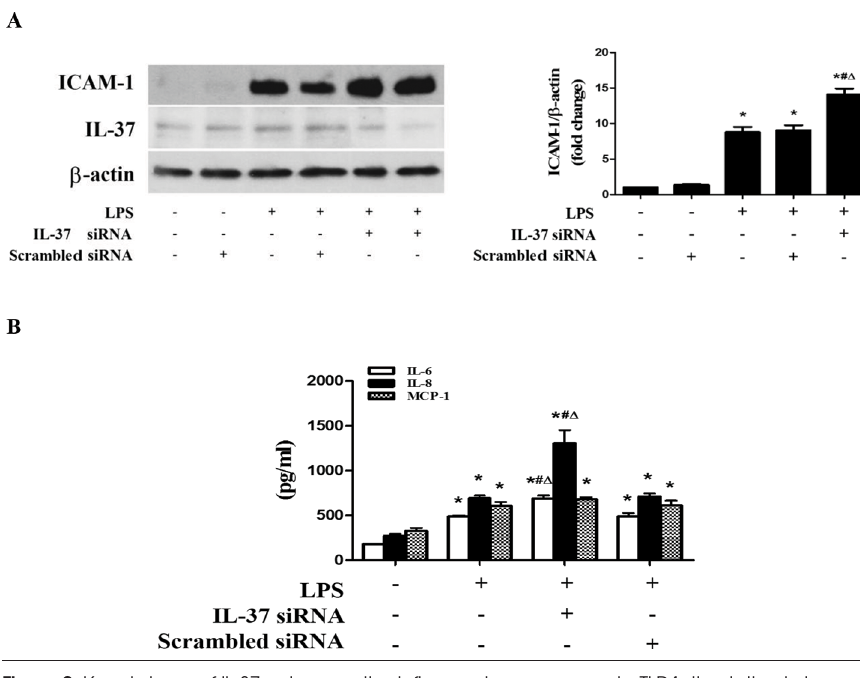
Figure 2. Knockdown of IL-37 enhances the inflammatory responses to TLR4 stimulation in human AVICs. AVICs were pretreated with IL-37 siRNA (60 nmol/L) or scrambled siRNA (60 nmol/L) for 48 h and then treated with LPS (0.1 μ g/mL) for 24 h. (A) A representative immunoblot shows that cells treated with IL-37 siRNA + LPS had lower levels of IL-37 protein compared to cells treated with LPS alone or scrambled siRNA + LPS. Densitometric data and representative immunoblot show that cells treated with IL-37 siRNA + LPS produced higher levels of ICAM-1. (B) Cytokine data show that knockdown of IL-37 enhanced the production of IL-6 and IL-8, but not MCP-1, induced by LPS. Data are mean ± SE. n = 5 experiments using cell isolates from distinct donor valves; * P <0.05 versus control; # P <0.05 versus LPS alone; Δ P < 0.05 versus scrambled siRNA +